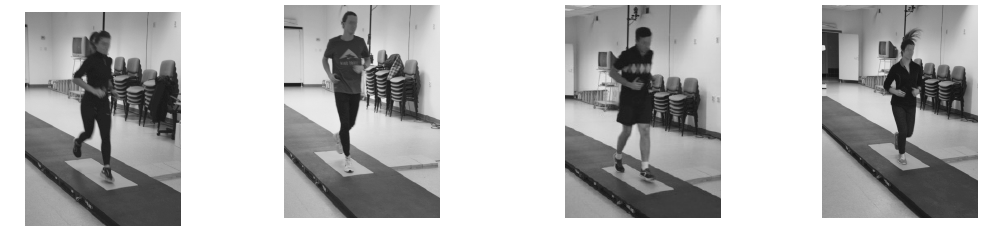
Figure 2. Running volunteers during the experiment (grey rectangle—the region of force measurement).